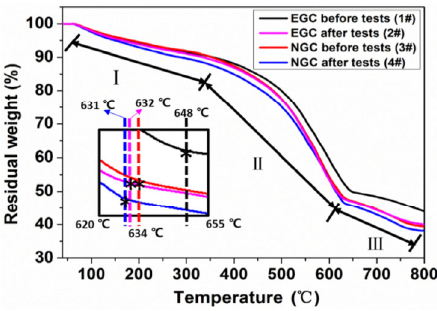
Fig. 9 TGA curves of friction composites before and after